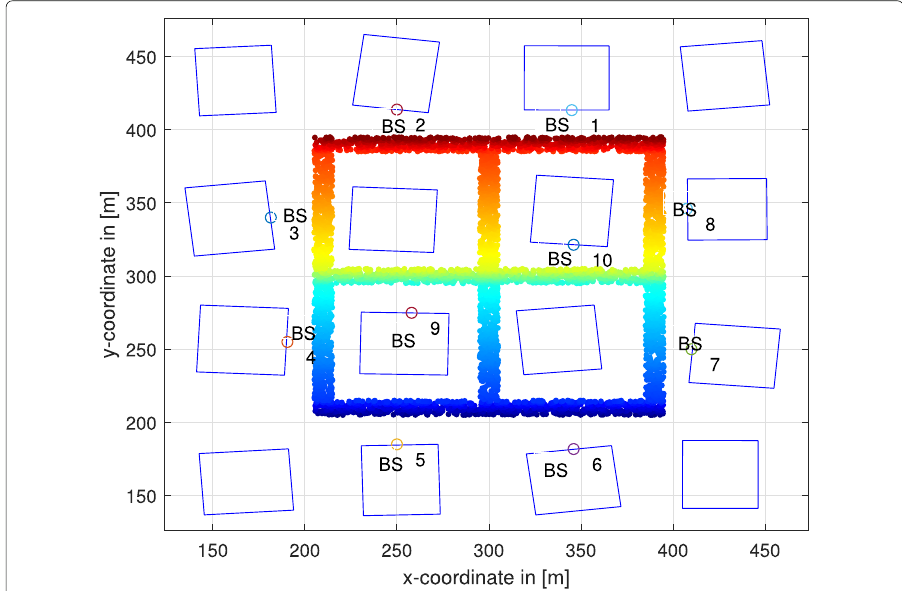
Fig. 5 Simulated scenario: streets in a Manhattan grid with 10 BSs labeled by numbers and sampled UE locations marked by